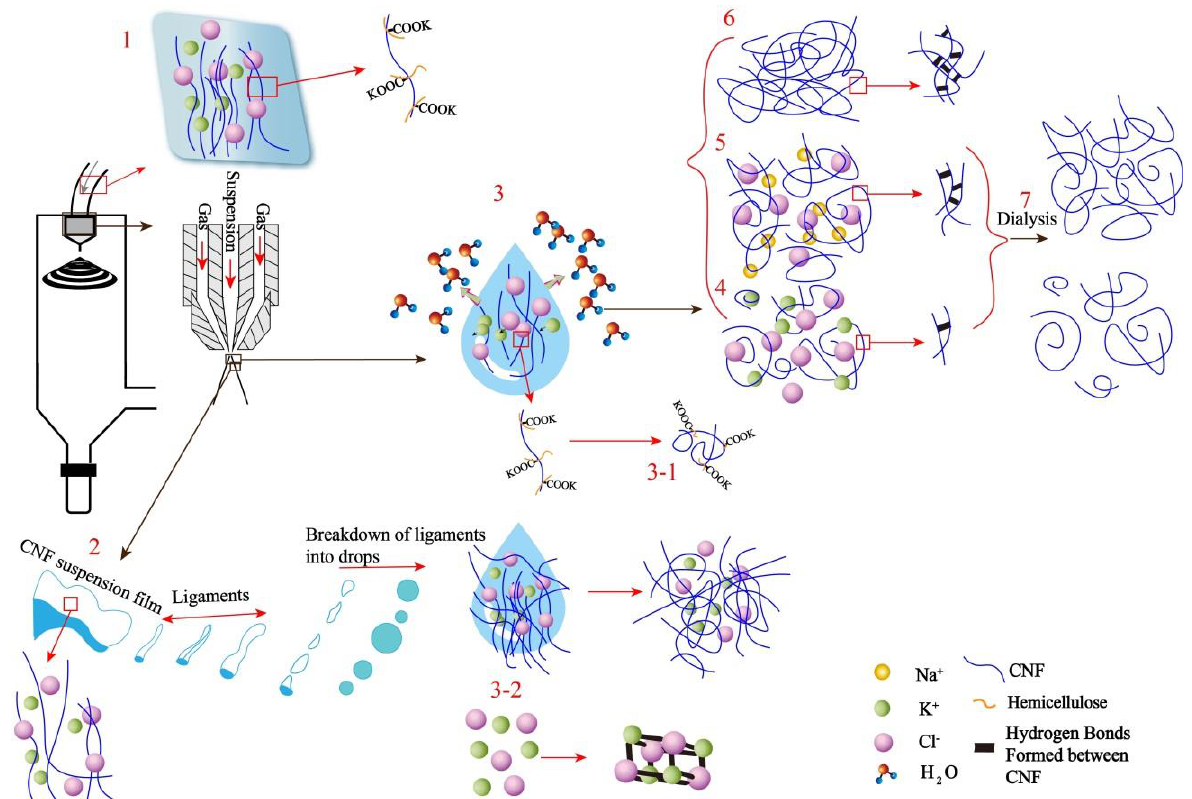
Figure 7. Schematic of proposed interaction between CNF and KCl (or NaCl) under spray drying.